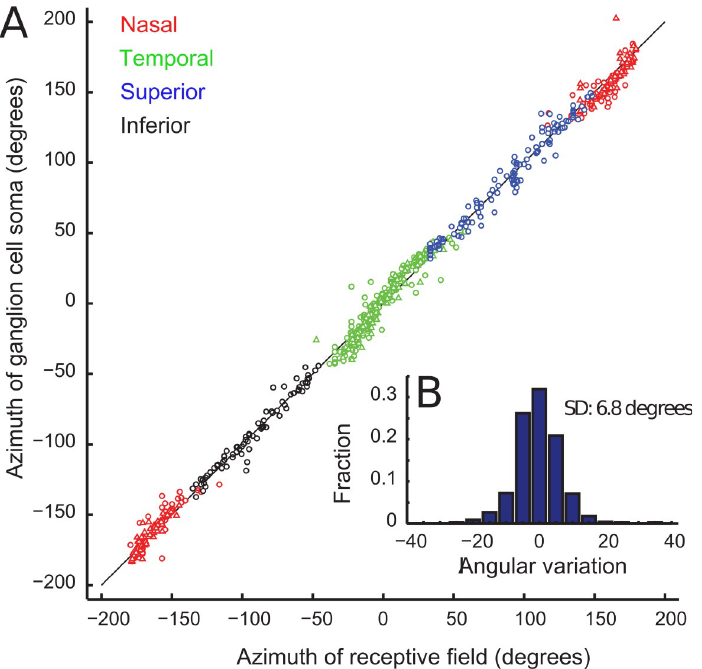
Fig 4. Preservation of receptive field azimuth in the location of GCs in the dilated foveal ring. a.) Biplot of the azimuth of individual retinal ganglion cells versus the azimuth of the measured receptive field of each ganglion cell. Color of symbols show results for nasal, temporal, superior and inferior directions from the fovea center. b.) Distribution of the angular difference between azimuths of GC somas and the azimuth of the receptive fields, centered around 0.38 degrees and with a standard deviation of 6.8